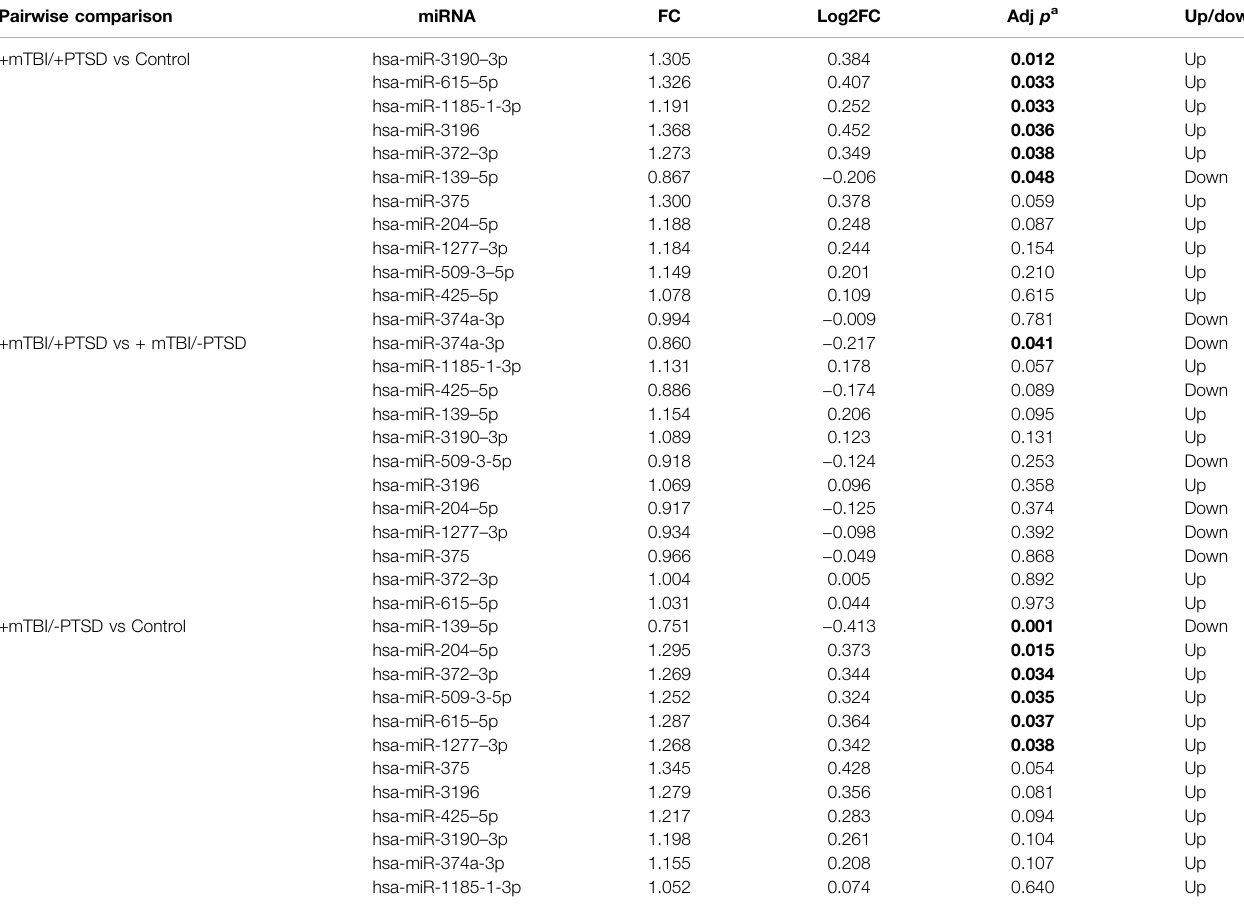
TABLE 2 | Differentially regulated miRNAs in group comparisons. Pairwise comparison miRNA +mTBI/+PTSD vs